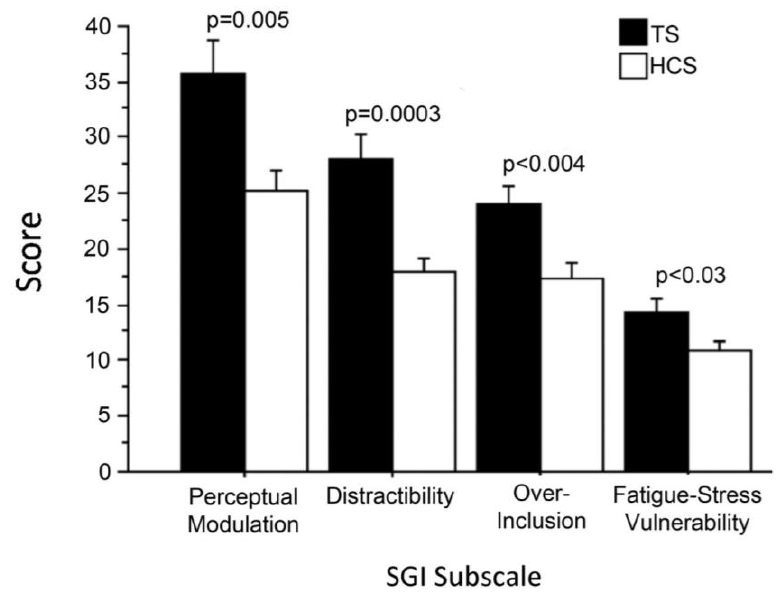
FIGURE 1. SGI subscales in TS subjects and HCS. Data are collapsed across age groups and gender. ANOVA detected a significant effect of diagnosis and a significant diagnosis  subscale interaction. Post-hoc significance values for patients vs. controls are shown for each